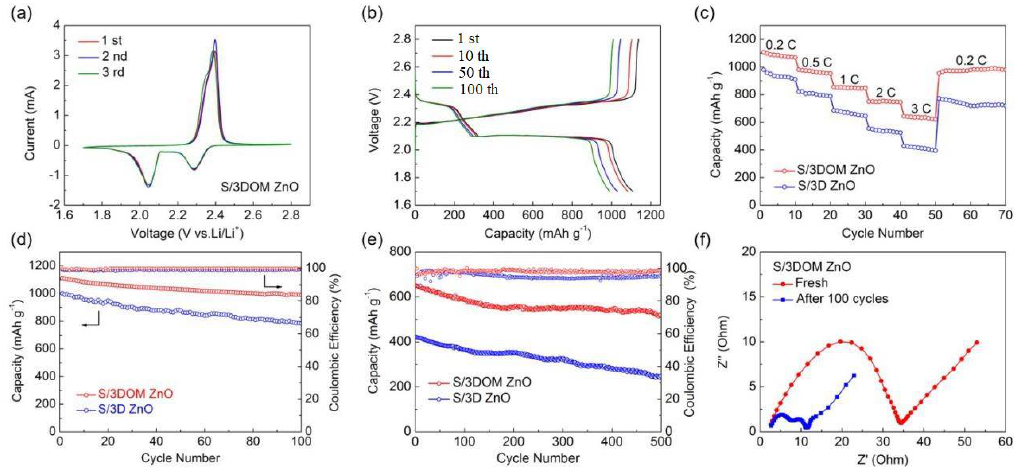
Figure 7. ( a ) CV curves of S / 3DOM ZnO at 0.1 mV s − 1 ; ( b ) galvanostatic charge / discharge profiles of S / 3DOM ZnO electrode at 0.2 C; ( c ) rate performance of S / 3DOM ZnO and S / 3D ZnO electrodes at di ff erent C-rates; ( d ) cycling performance at 0.2 C and ( e ) long-term cycling performance at 3 C of S / 3DOM ZnO and S / 3D ZnO electrodes; ( f ) Nyquist plots of S / 3DOM ZnO electrodes before and after 100